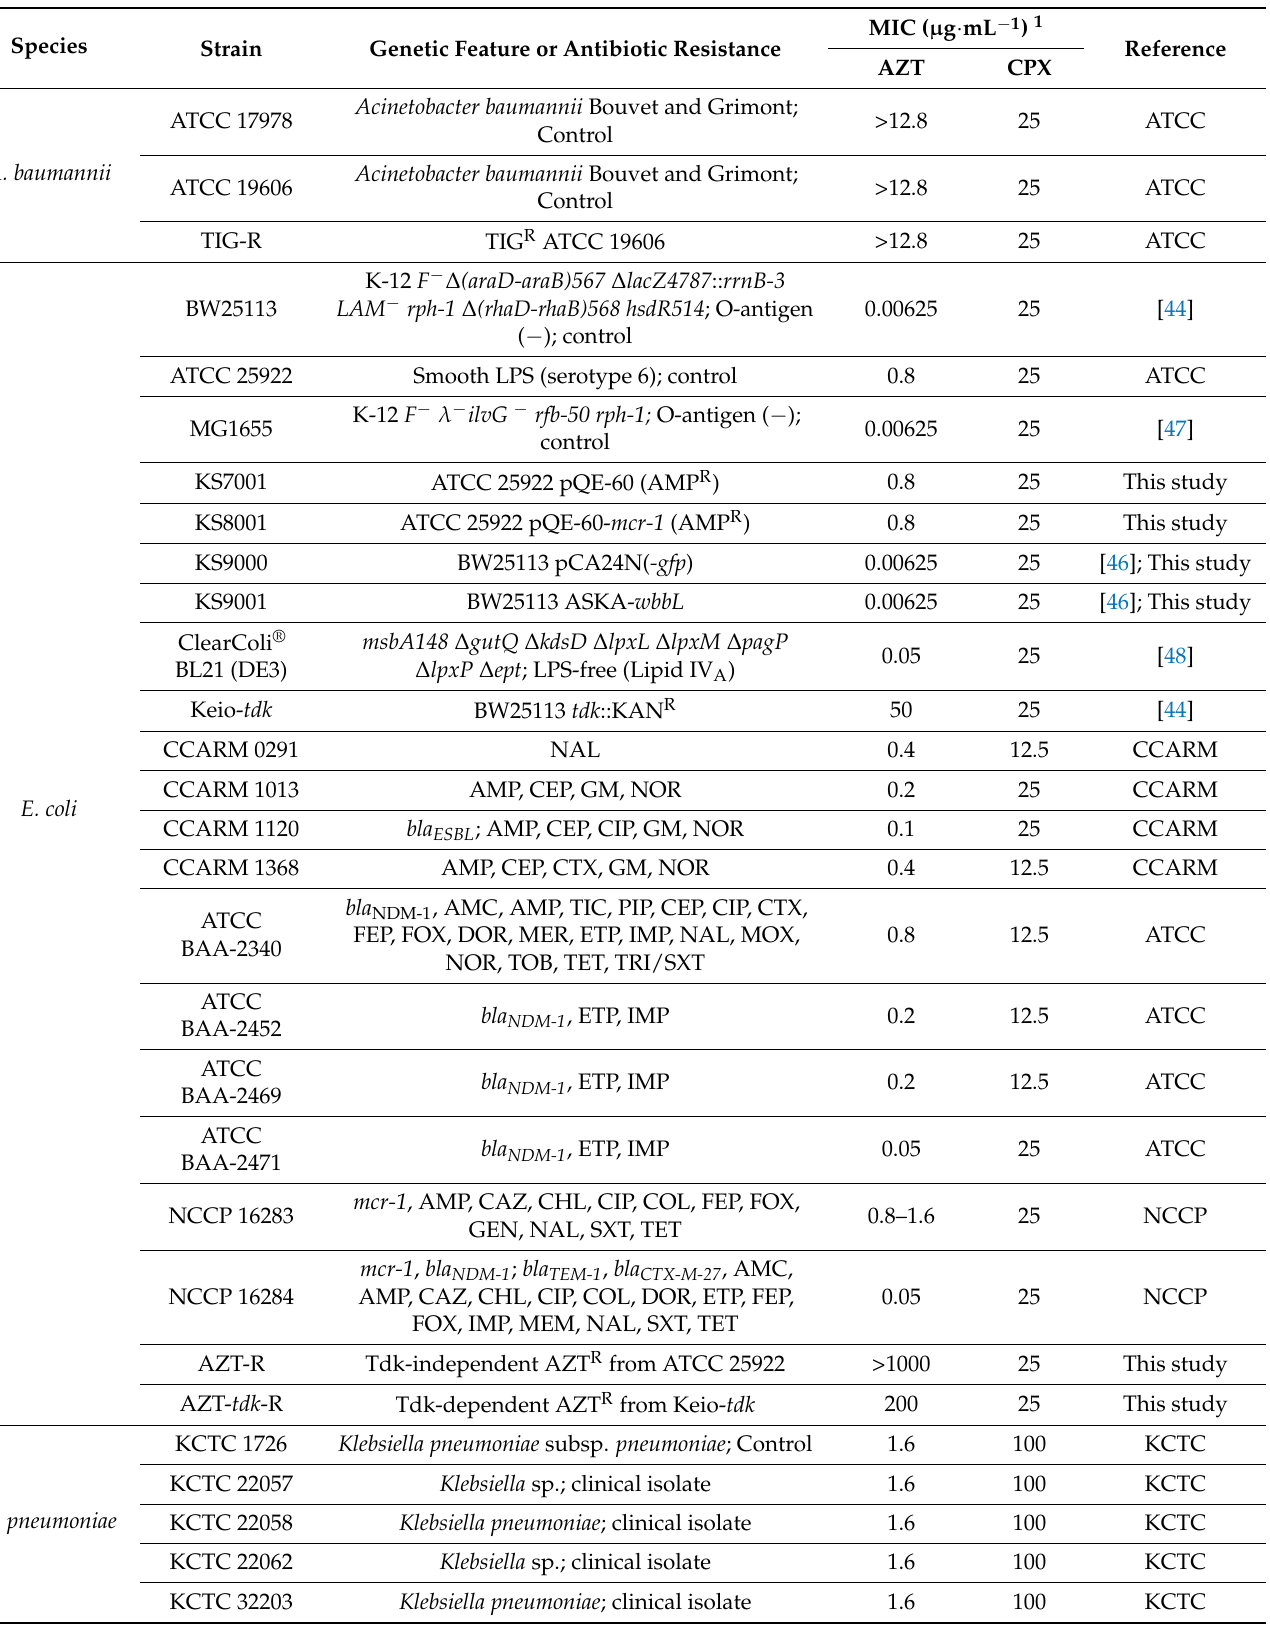
Table 1. Minimum inhibitory concentrations (MICs) of test antibiotics against Gram-negative bacterial